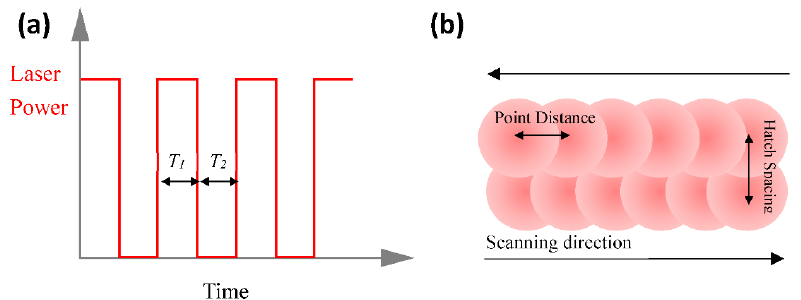
Figure 3. The waveform of the modulated pulsed laser power output ( a ) and the laser working mode ( b ). Table 1. The process parameters in simulation and experiments.